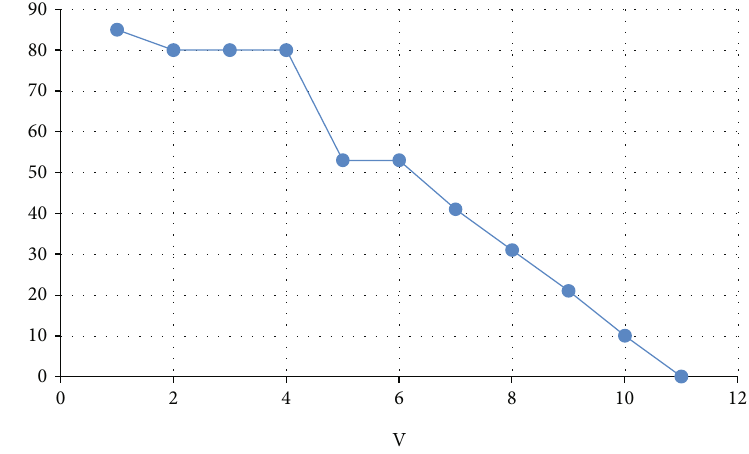
Figure 7: Overland PV on the I-V curve.